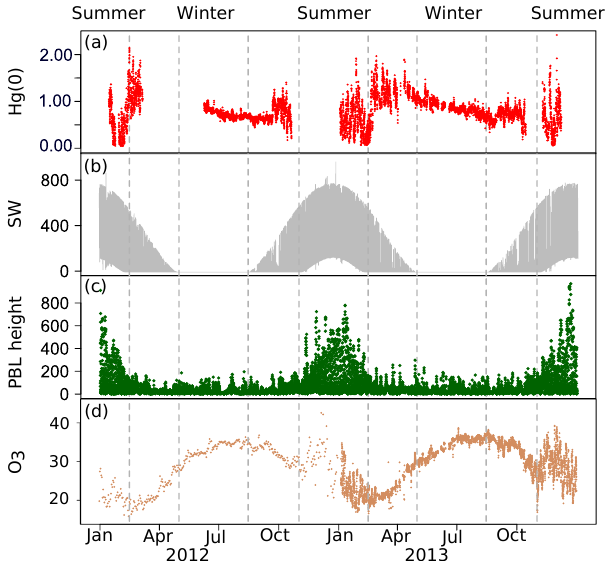
Figure 3. Annual variation in 2012 and 2013 of (a) hourly averaged Hg(0) concentrations (in ngm − 3 ) at 500 and 25cm above the snow surface in 2012 and 2013, respectively, (b) downwelling shortwave (SW) radiation (in Wm − 2 ), (c) planetary boundary layer (PBL) height (in m), and (d) ozone (O 3 , daily mean in 2012 and hourly mean in 2013) mixing ratios (in ppbv). The vertical dashed lines represent seasonal boundaries.